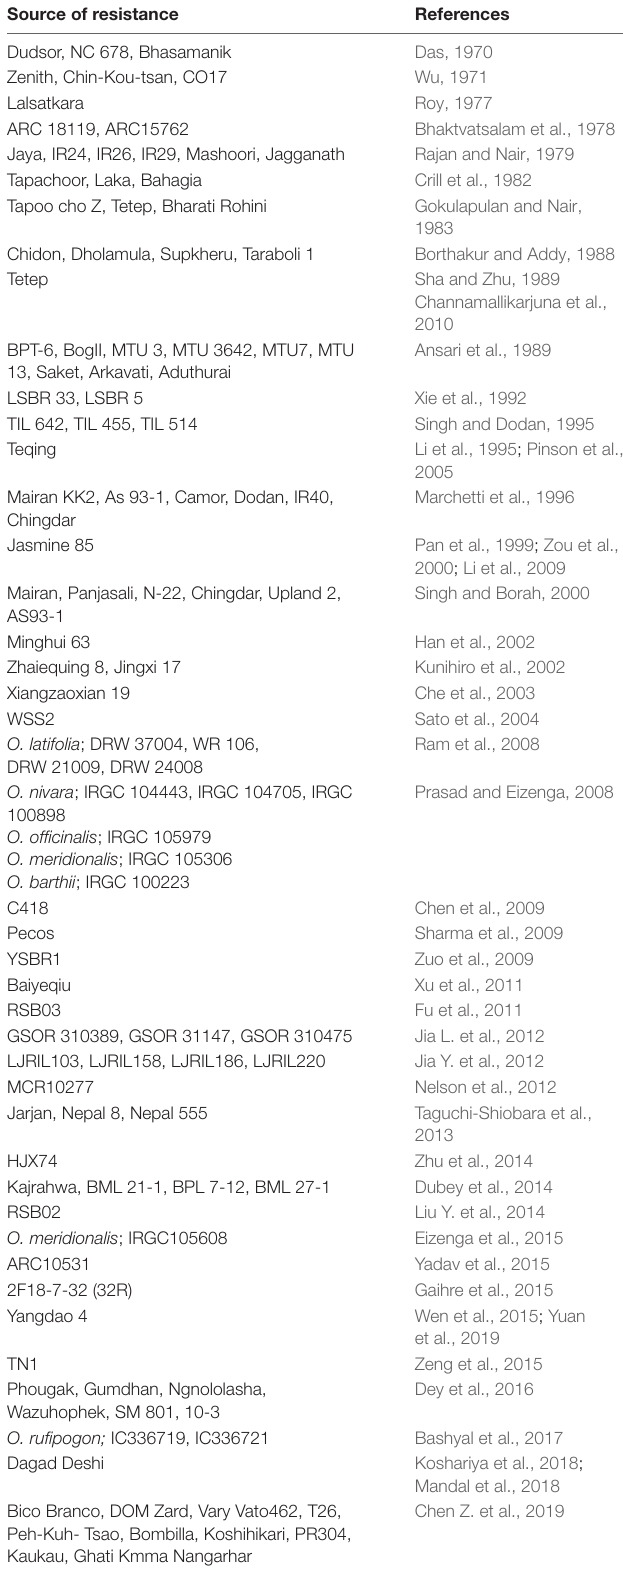
TABLE 3 | Rice genotypes identified as sources of resistance to sheath blight disease. Source of